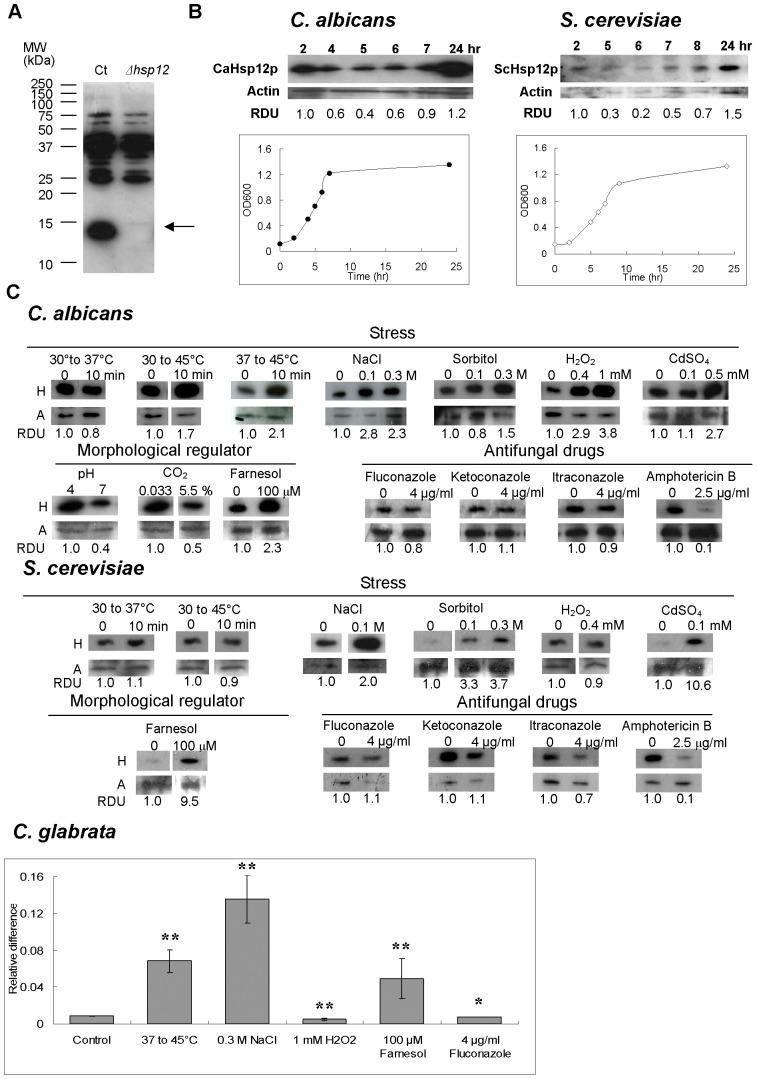
Hsp12p is regulated in response to a wide range of stresses.(A) CaHsp12p is recognized by a polyclonal antibody. The anti-CaHsp12p antibody was tested by using Western blot analysis against protein samples from the C. albicans CAI4 control strain (Ct) and the Cahsp12 null mutant (Δhsp12). The arrow indicates the 13 kDa band of CaHsp12p which is present in CAI4, but absent in the Cahsp12 null mutant. (B) Induction of Hsp12p in C. albicans and in S. cerevisiae during stationary growth. Total protein was extracted at the indicated time points from C. albicans CAI4 at 37°C or S. cerevisiae BY4741 at 30°C. Western blots were probed with anti-Hsp12p antibody and showed a band corresponding to the expected size of 13 kDa. Blots were probed with anti-actin antibody as loading control. Growth curves with sampling time points (open or solid dots) are shown. RDU: relative densitometry units. (C) Hsp12p is regulated in response to diverse conditions. Hsp12 protein level in C. albicans CAI4 or S. cerevisiae BY4741 was assayed using Western blot and a band of the expected size (13 kDa) was detected. H: anti-Hsp12p antibody. A: anti-actin antibody (equal protein loading control). RDU: relative densitometry units. CgHSP12 transcript level was determined by qRT-PCR with total RNA extracted from the Cg2001TU strain. The transcript level was normalized to the Act1 control. The error bars represent the S.D. of triplicate independent reactions. **P value<0.01, * P value>0.3, two-sided unpaired student t-test.